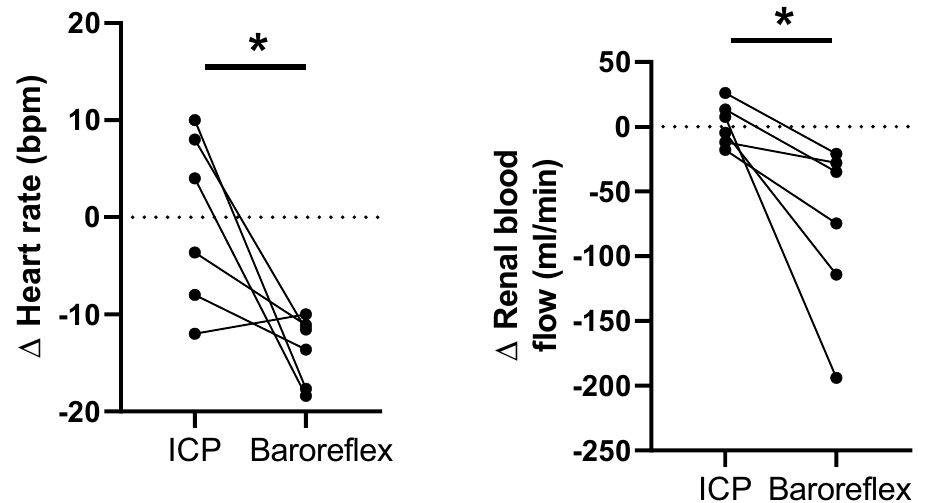
Figure 6. The change in heart rate and renal blood flow during the intracranial pressure challenge is compared to the changes during equivalent increases in arterial pressure during the baroreflex challenge in normotensive sheep. * significant difference between the two